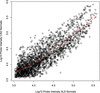
The computational experiment workflow, showing decision points for the algorithmic steps making up the method used, ending in the determination of differentially expressed genes (LO-BaFL vs. TM4 for processing and R-Wilcoxon vs. Sam-Wilcoxon for test implementation).